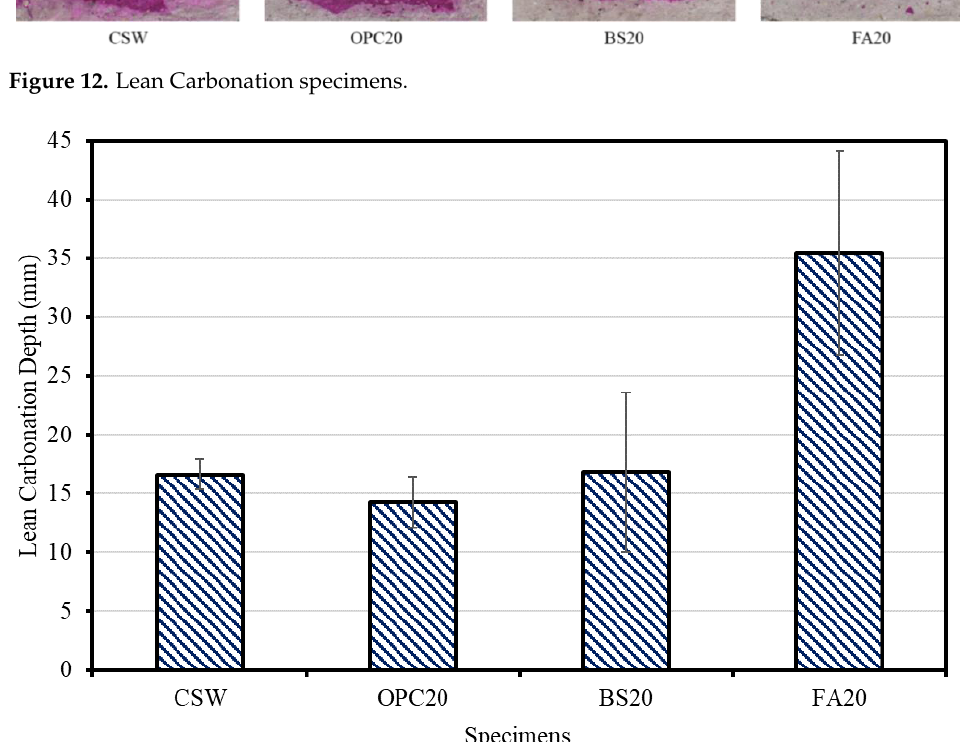
Figure 13. Lean Carbonation depth measurement results.